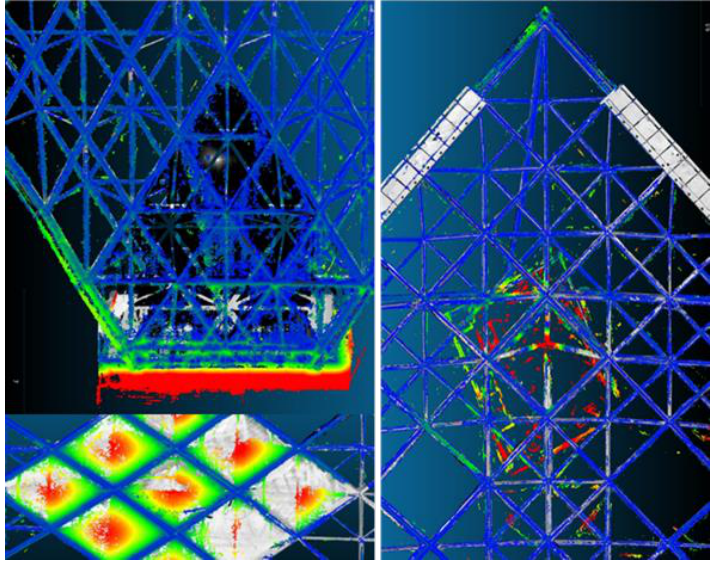
Figure 32. Deviation analysis on the total dense point cloud between the TLS and RPAS data.